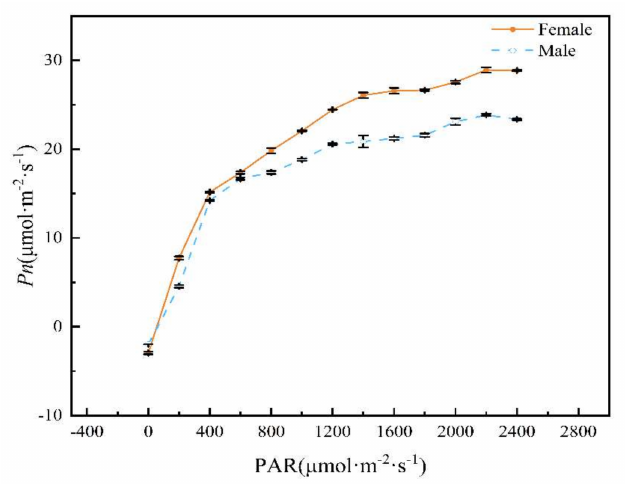
Figure 2. Pn-PAR curves of male and female plants of H. tibetana, all measured in early August